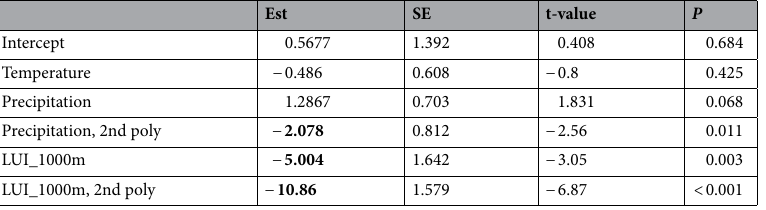
Table 3. Spatio-temporal drivers of overall ground beetle activity density. The generalized least squares model included an autoregression term to account for temporal autocorrelation, a grouping factor of site nested within region to account for repeated sampling within sites. Estimates are shown in bold when significant. Second order polynomial terms are denoted as “2nd poly”.